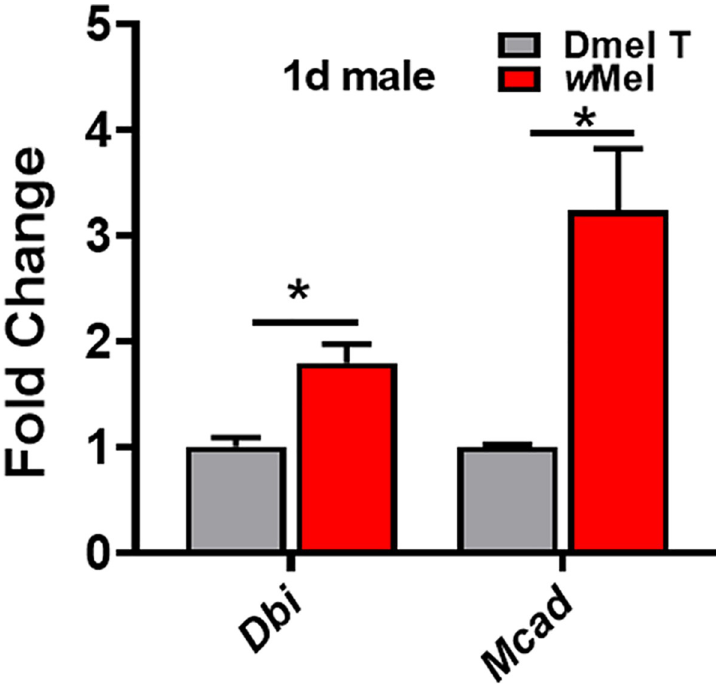
Fig 6. Wolbachia infection upregulated the transcription of Dbi and Mcad . Dmel T: uninfected flies; w Mel: Wolbachia -infected flies. � P <